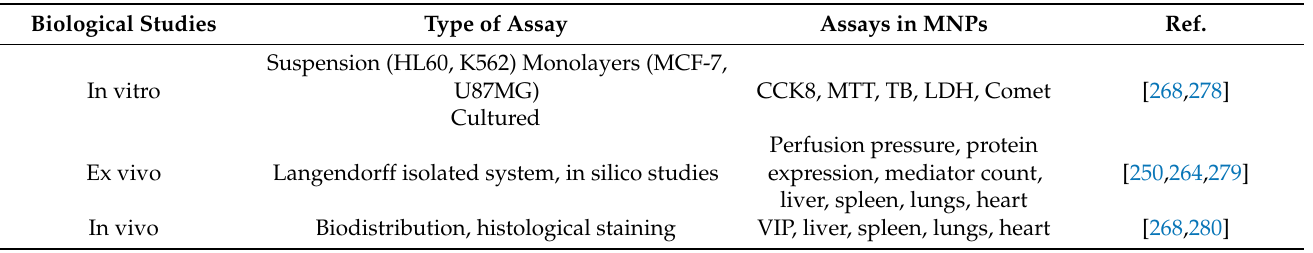
Table 3. Biological assessment of treatments for